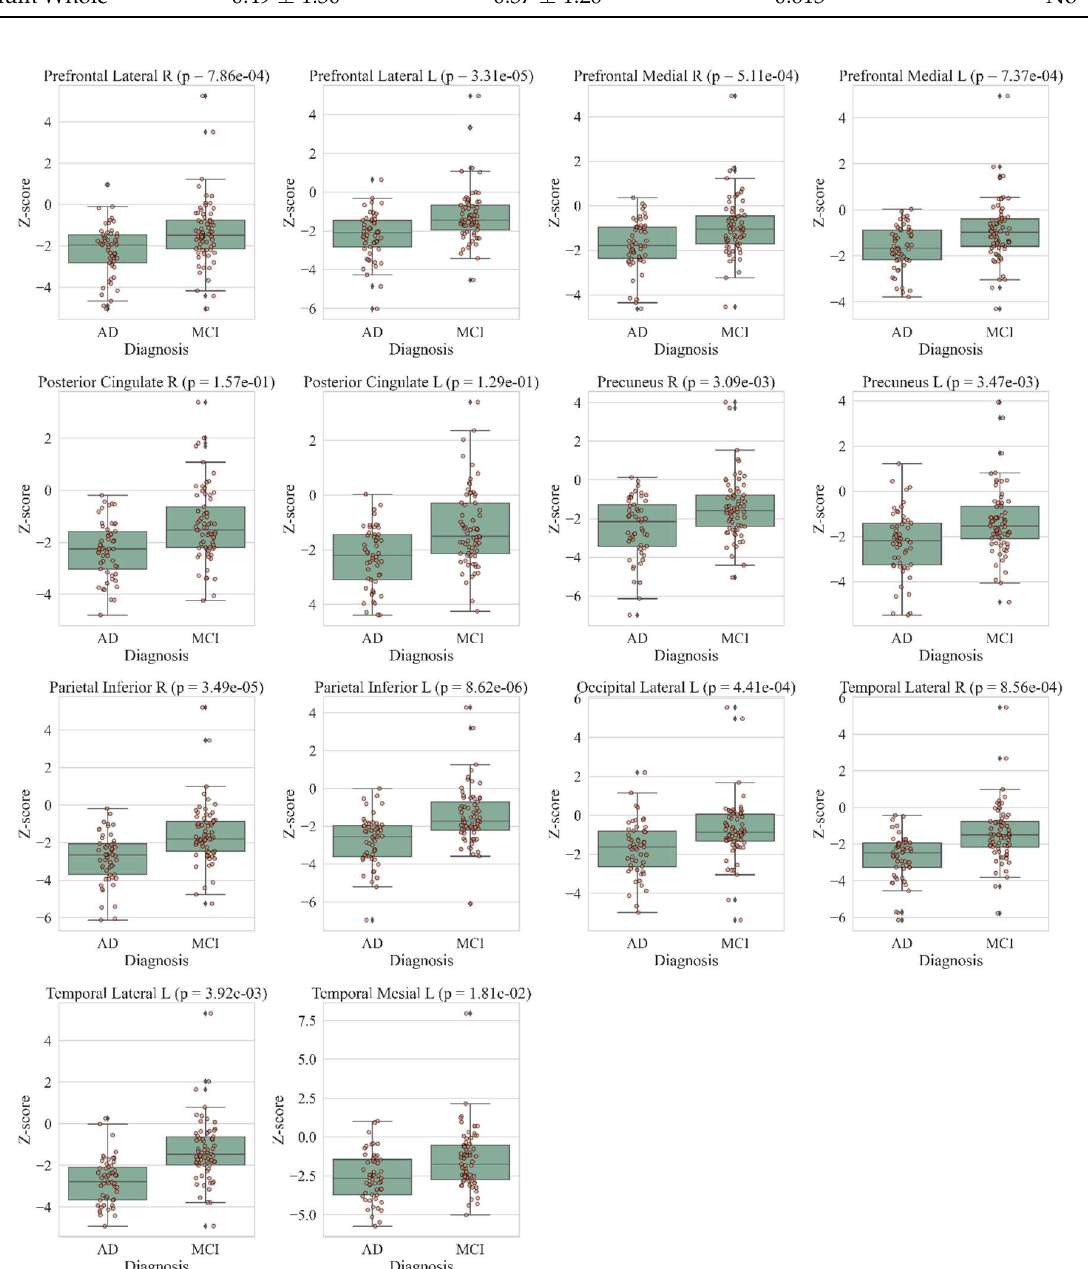
Figure 3. Box-plots and strip-plots of the Z-score for each area with significant difference between AD and MCI.